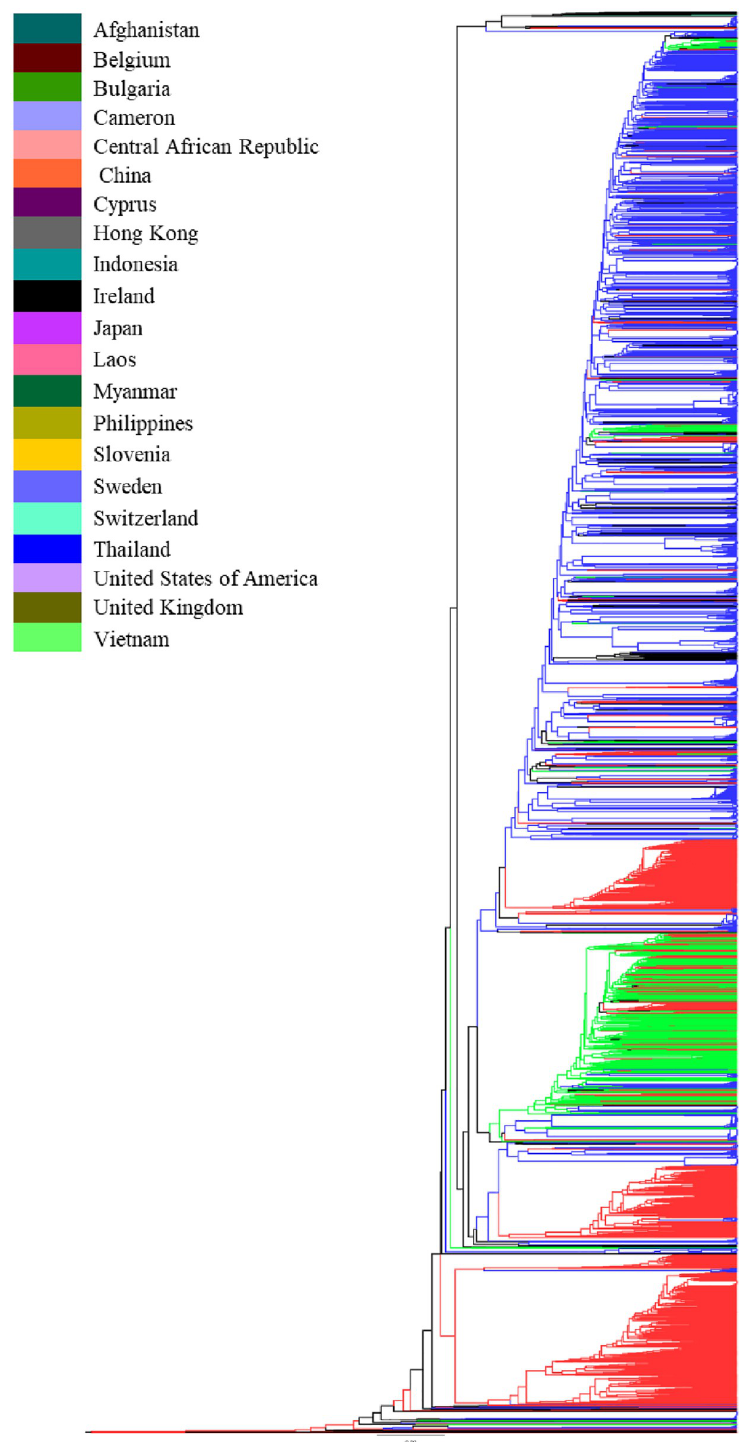
Fig 2. Maximum likelihood (ML) tree of HIV-1 CRF01_AE gag gene sequences. ML tree was used to infer the phylogenetic relationship among the 3105 HIV-1 CRF01_AE gag sequences submitted to the LANL HIV Sequence Database, representing the years 1990 to 2017. The tree was color-coded based on the countries. The color key for the tree is given within the figure.